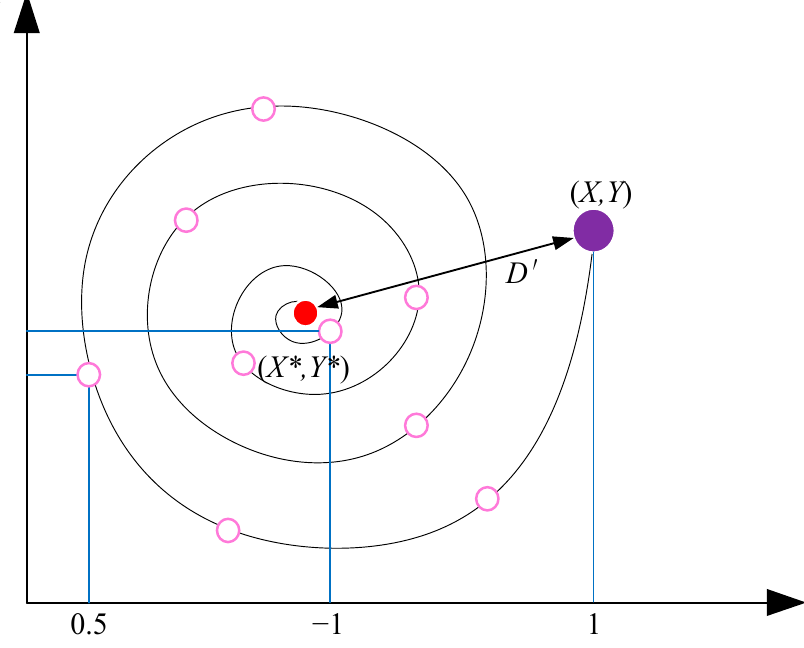
Figure 2. Spiral bubble netting for hunting.